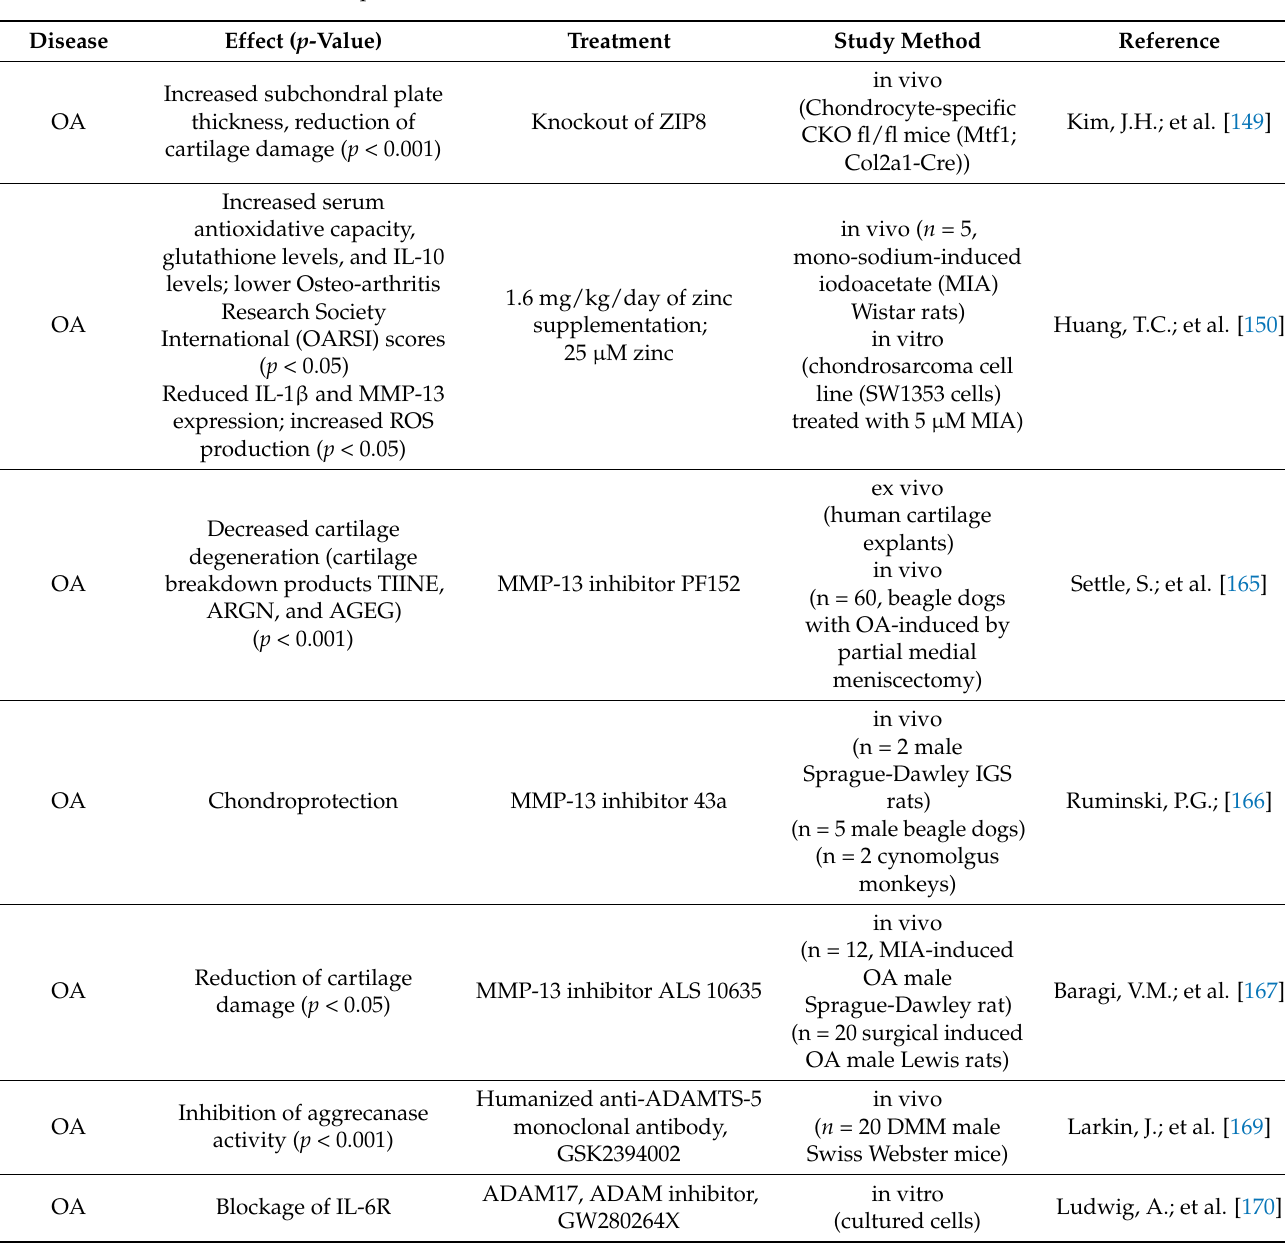
Table 2. Therapeutic interventions with zinc in osteoarthritis and rheumatoid arthritis.